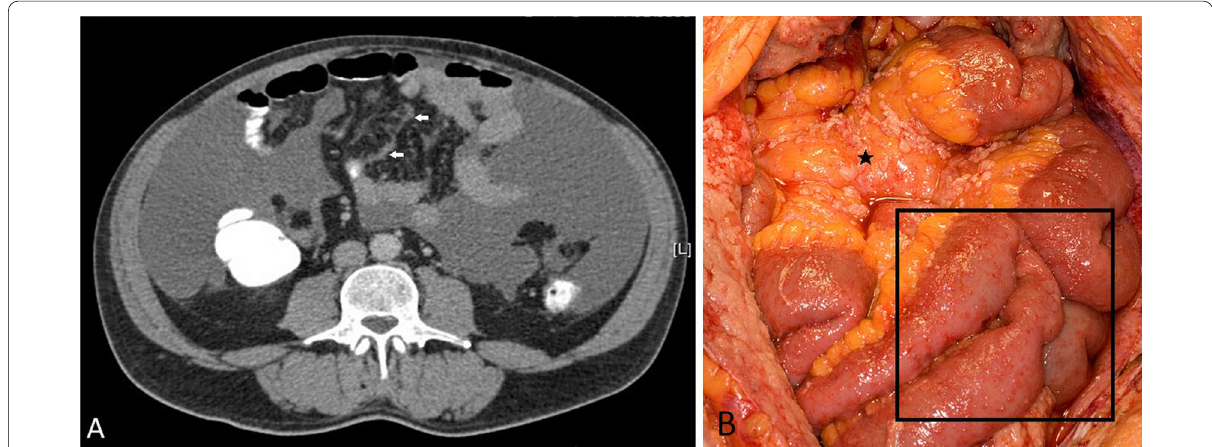
Fig. 19 a , b Patient with epithelioid peritoneal mesothelioma. a CT shows ascites and subtle mesenteric nodularity (arrows). b Photograph from diagnostic laparoscopy showing diffuse mesenteric nodules (asterisk) and diffuse small bowel serosal nodules (black rectangle)